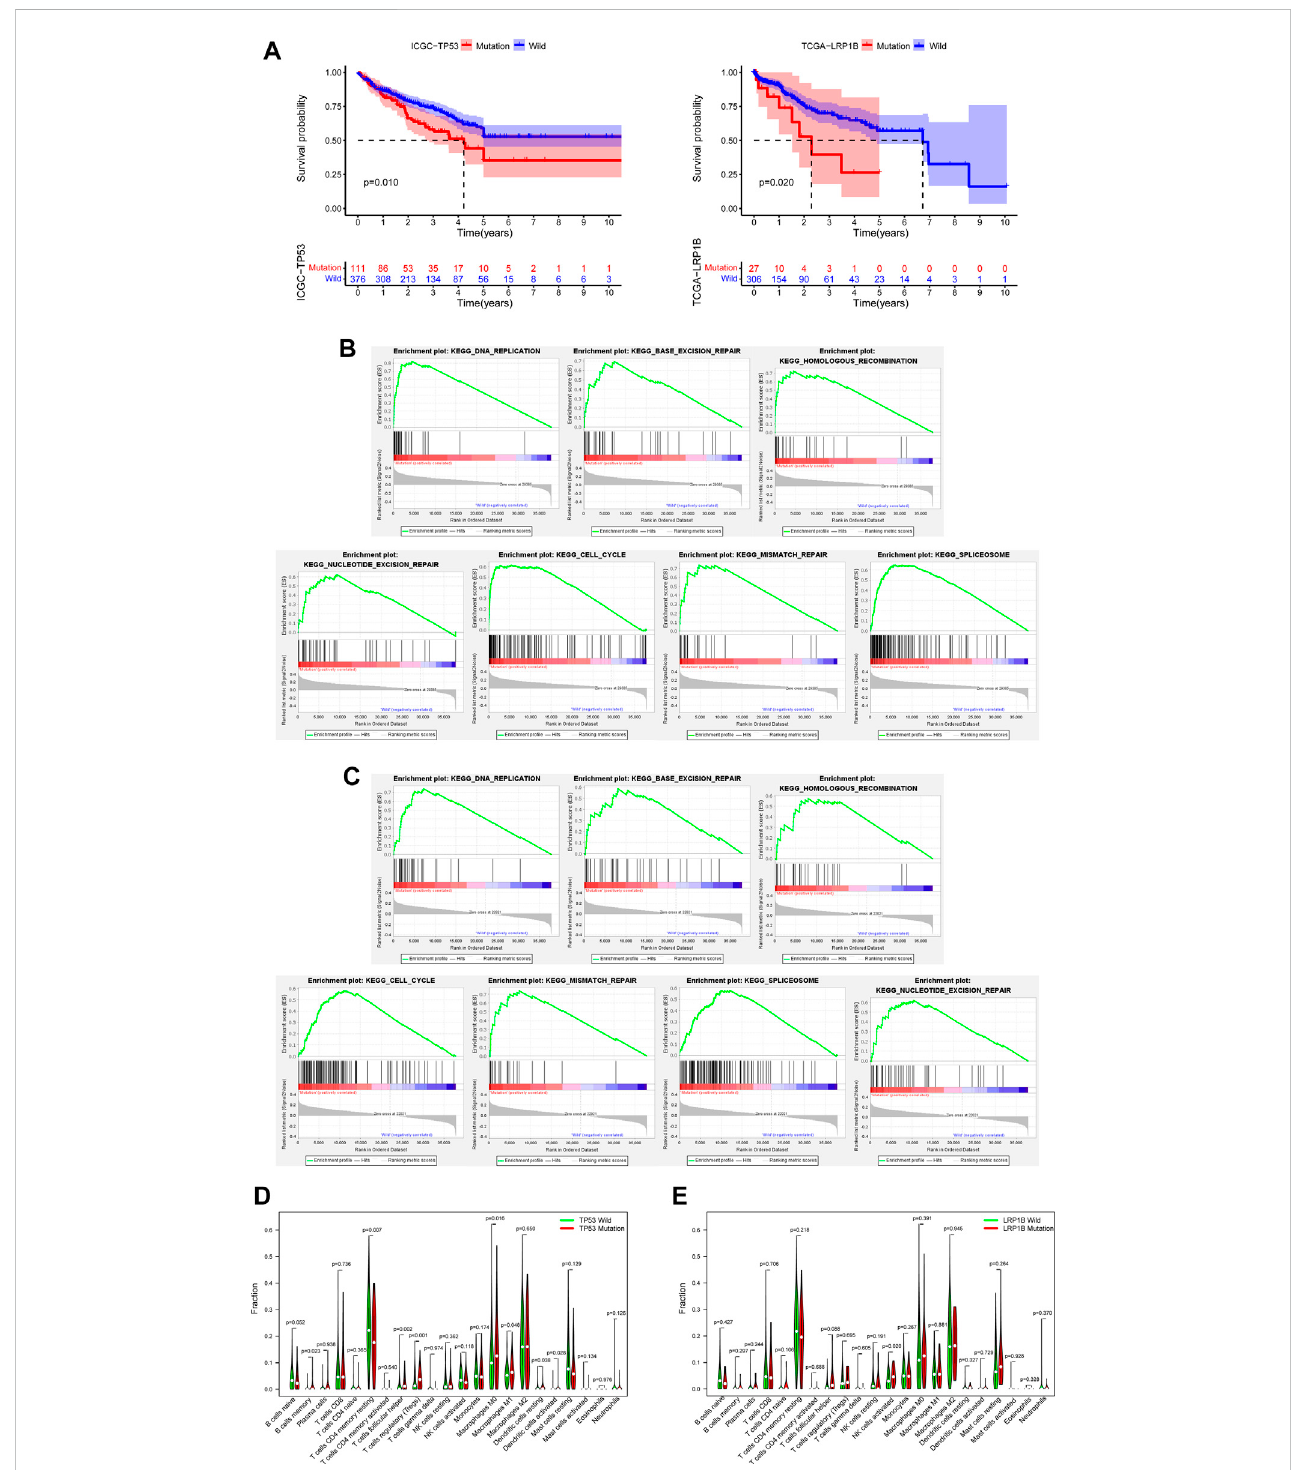
FIGURE 3 Veri fi cation of the database and biological characteristics related to TP53 mutation and LRP1B mutation. (A) Kaplan-Meier survival analysis was performed on the mutation data with clinical information in TCGA and ICGC databases. (B) GSEA enrichment analysis showed that the pathway was signi fi cantly related to TP53 mutation. (C) GSEA enrichment analysis showed that the pathway was signi fi cantly related to LRP1B mutation. (D) The difference of immunocyte in fi ltration abundance between TP53 mutation group and wild group in HCC patients. (E) The difference of immunocyte in fi ltration abundance between LRP1B mutation group and wild group in HCC